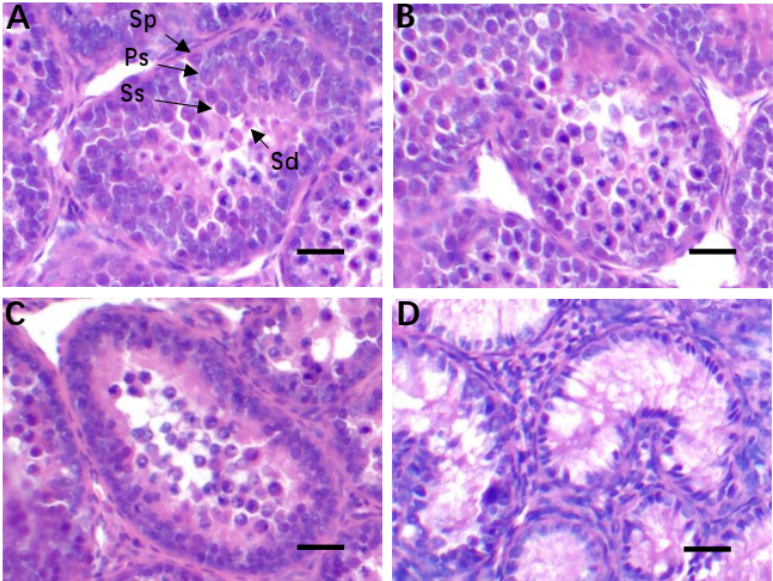
Figure 1. Observations of histological changes in testicular tissue of chickens exposed to heat stress (Hematoxylin and eosin staining). ( A ) Control group; ( B ) Alpha lipoic acid (ALA) treatment group; ( C ) Heat stress (HS) with ALA treatment (ALA + HS) group; ( D ) HS treatment group. Sp: spermatogonium; Ps: primary spermatocyte; Ss: secondary spermatocyte; Sd: spermatid. Scale bar 40 μm.